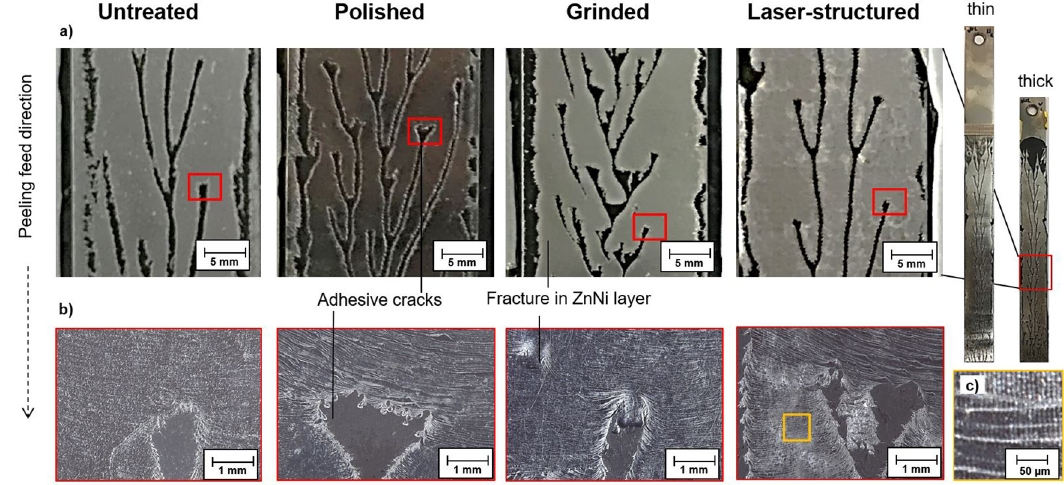
Fig. 8. Fracture pattern after roller peel test from ZnNi coated